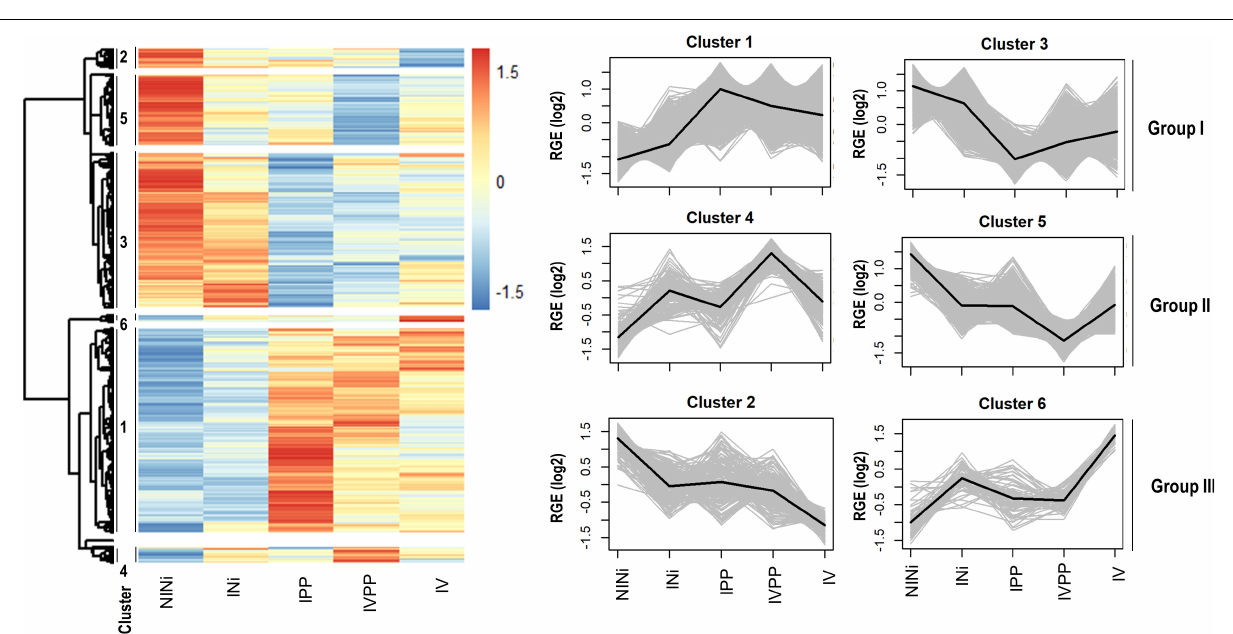
results in Tables 2 – 4 ). The “Glutathione metabolism” ( p - ( p -value = 2.53 × 10 − 4 ) categories are enriched for